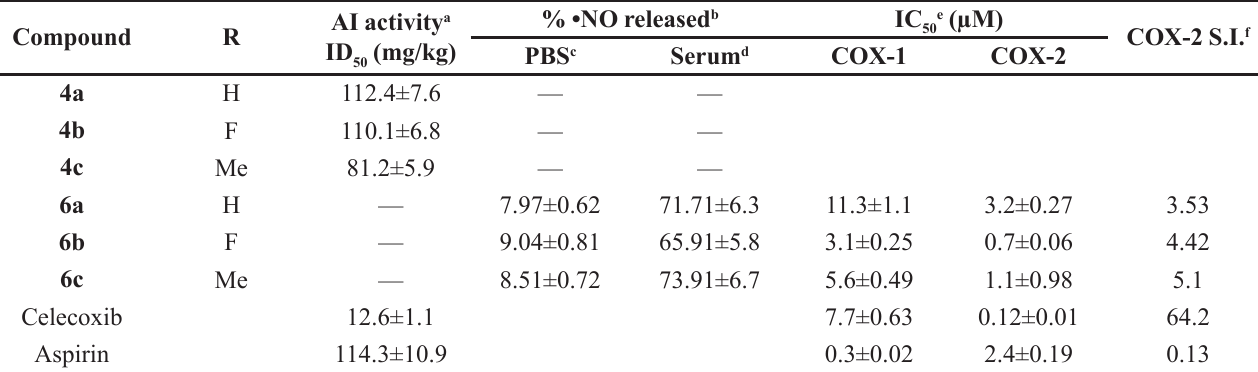
TABLE I - In vivo anti-inflammatory activities for 1-(4-methanesulfonylphenyl)-5-(4-substitutedphenyl)-1H-pyrazol-3-carboxylic acid ( 4a - c ), and percent (%) nitric oxide release, data for diazeniumdiolate pyrazole esters ( 6a - c ) and in vitro COX-1 and COX-2